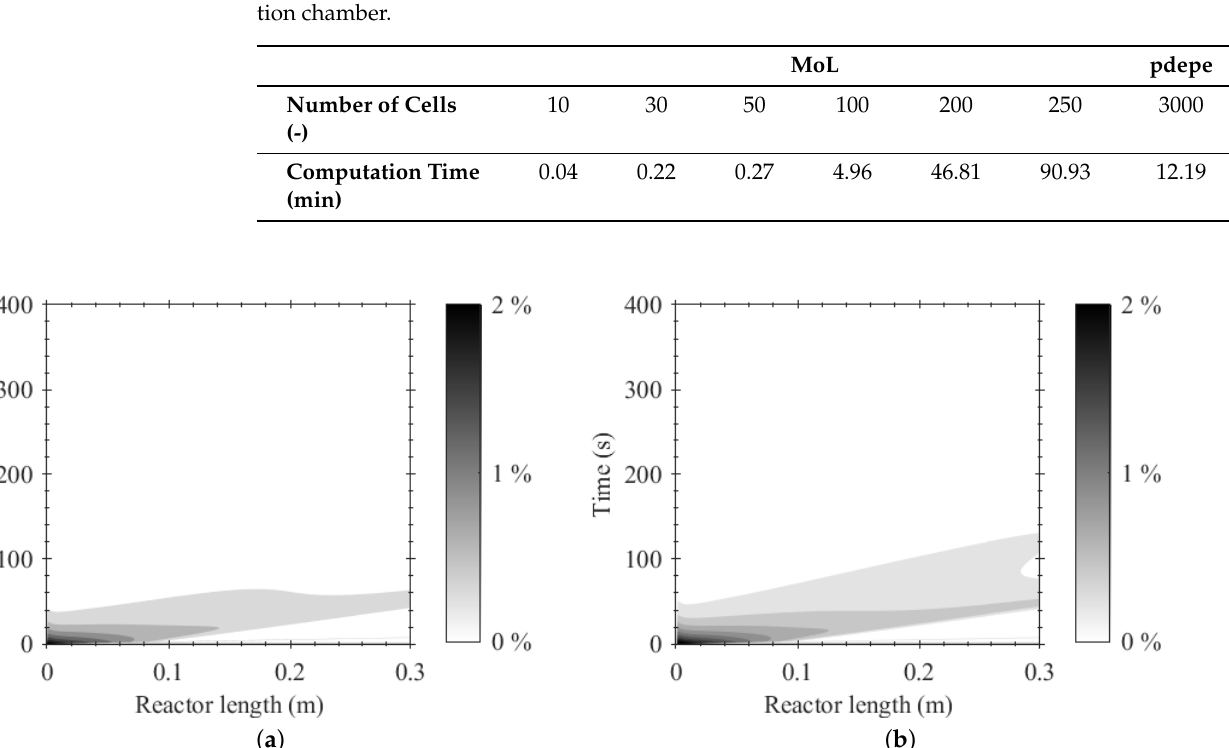
Figure A1. Time and space-dependent deviation from molar balance for reactive adsorption in one reaction chamber: ( a ) pdepe , and ( b ) MoL ( N = 100) simulation